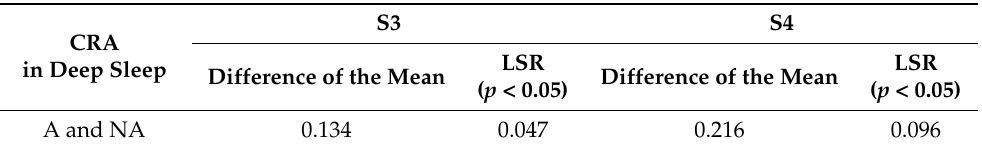
Table 1. Repeated one-way ANOVA and Dunnett’s post hoc test. If the value of difference of the mean > LSR, there is a significant difference between the groups being compared ( p = 0.004 < 0.05).